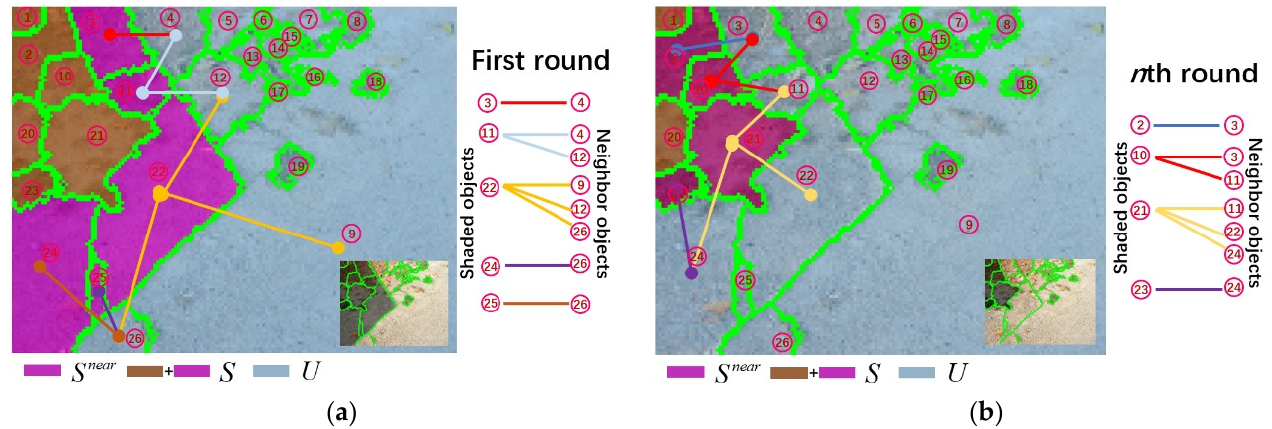
Figure 5. Schematic diagram of shadow compensation using adjacent objects information: ( a ) on the first round, the non-shadow objects directly adjacent to shadow objects were used to compensate their neighbor shadow objects; ( b ) on the n th round (here n = 2), the non-shadow objects executed shadow compensation on the ( n − 1)th and were utilized for shadow objects compensation.